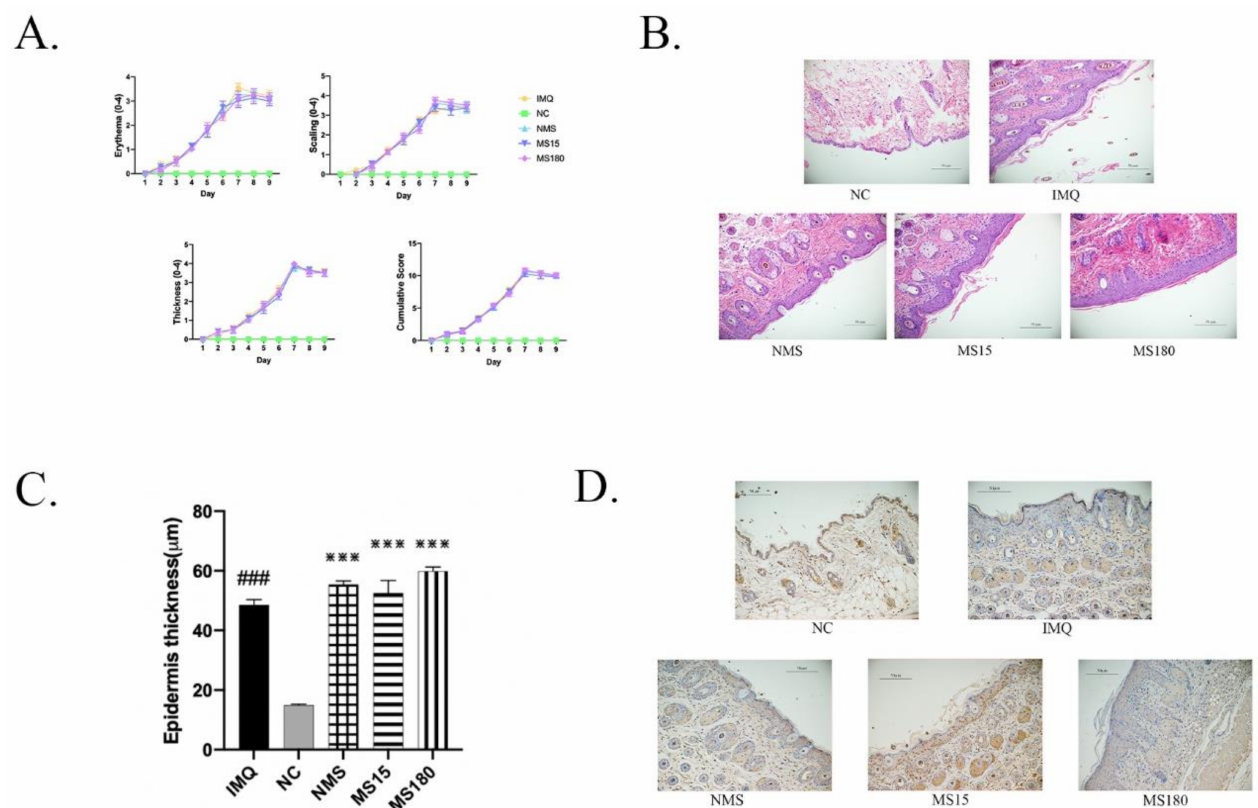
Figure 2. ( A ) The trend of PASI score in mice with skin lesions, which includes erythema score, scales score, thickness score, and cumulative score. Cumulative score = (Erythema score + Scales score + Thickness score). ( B ) Histopathological alterations in skin lesions following H&E staining (200), scale bar = 50 m. ( C ) Mice epidermal thickness in each group. ### p < 0.001 vs. the NC; *** p < 0.001 vs. the NMS; n = 10. ( D ) The immunohistochemical changes of NLRP3 in skin lesions ( × 200), scale bar = 50 µ